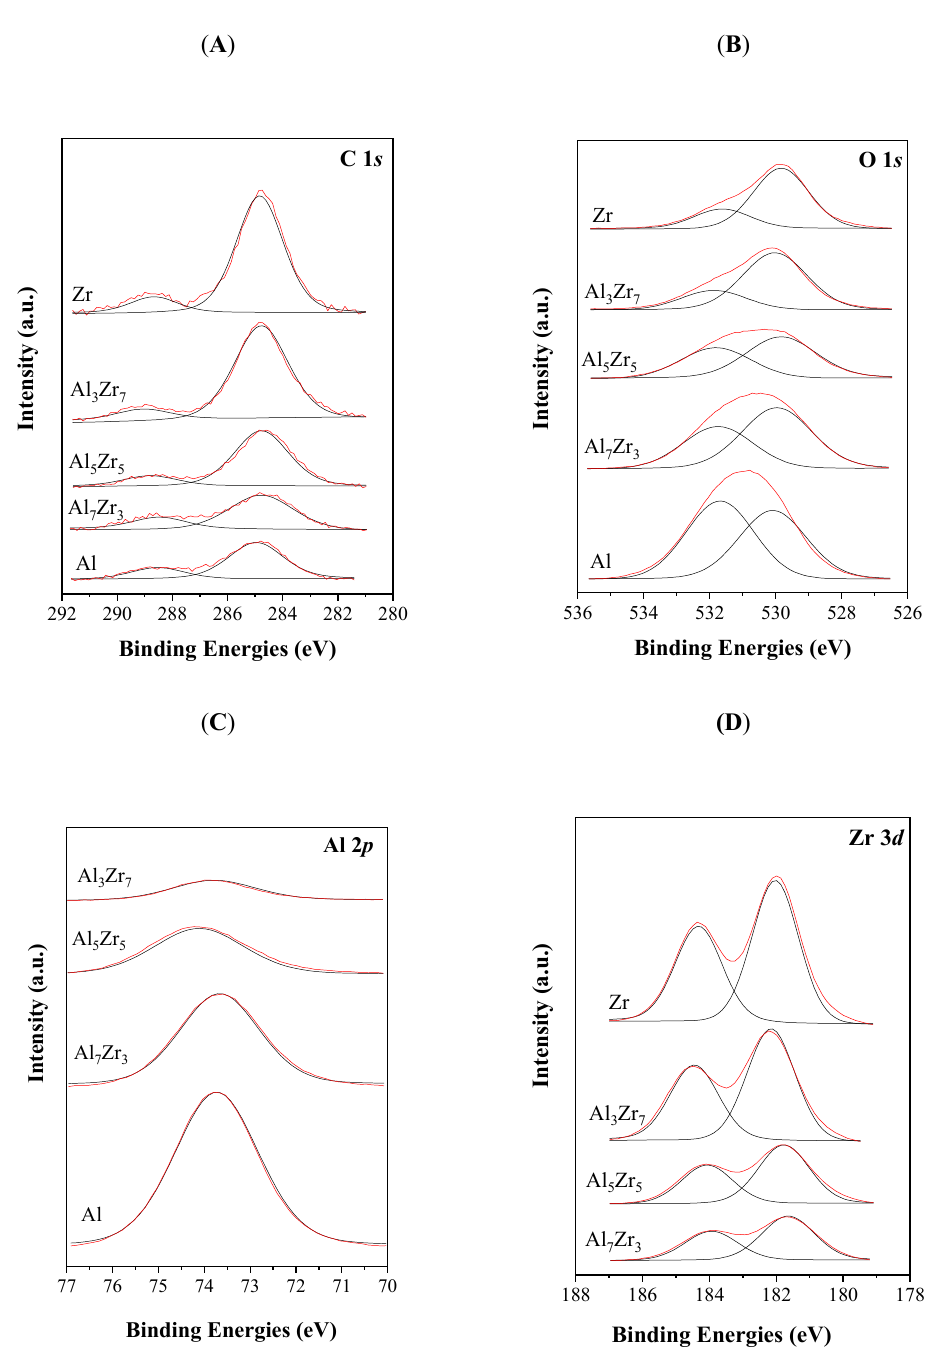
3 d 5 / 2 Figure 4. XPS spectra for Al, Zr, and Al x Zr y catalysts in the ( A ) C 1 s , ( B ) O 1 s , ( C ) Al 2 p , and ( D ) Zr 3 d 5/2 regions.